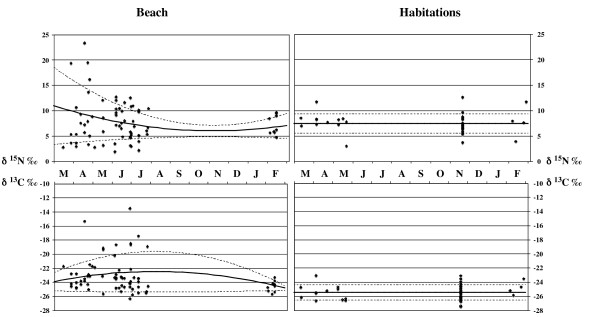
Selected models for δ13C and δ15N from cuticle of mole crickets caught on the beach or near habitations. The envelope is the selected model for ± 2 SD.